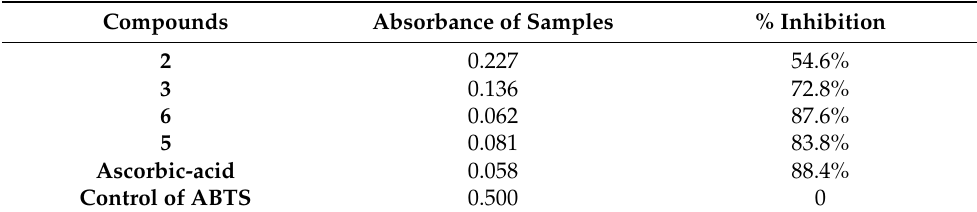
Table 1. Antioxidant assay for the tested new compounds.